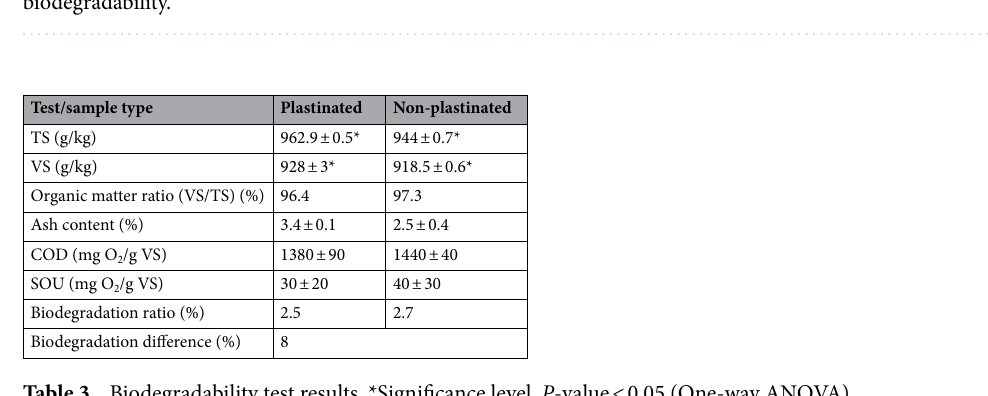
Figure 6. ( a ) Ogogrow compost with white rot fungi. ( b , c ) Reactors used in the SOU test and set-up. Residual ash content of the ( d ) plastinated and ( e ) non-plastinated bamboo present after heating for 2 h at 550 °C. ( f ) The specific oxygen consumption of the plastinated and non-plastinated samples used to calculate the aerobic biodegradability.